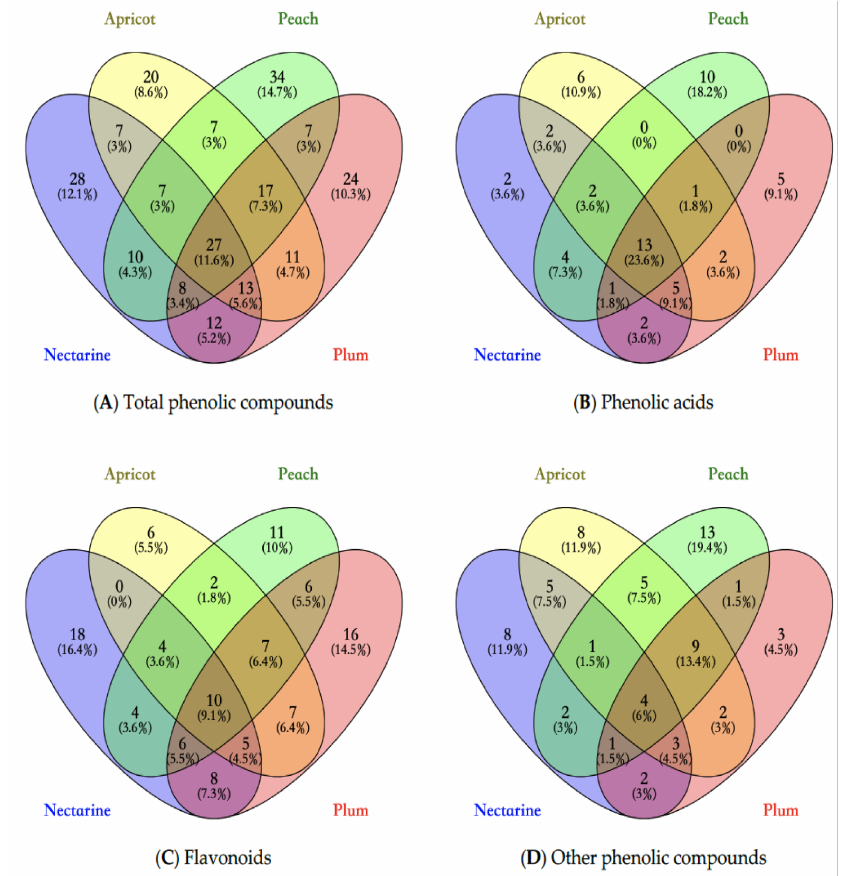
Figure 1. Venn diagram of phenolic compounds presented in stone fruits waste samples. ( A ) shows the relations of total phenolic compounds present in stone fruits waste; ( B ) shows the relations of phenolic acids in present in stone fruits waste; ( C ) shows the relations of flavonoids present in stone fruits waste; ( D ) shows the relations of other phenolic compounds present in stone fruits